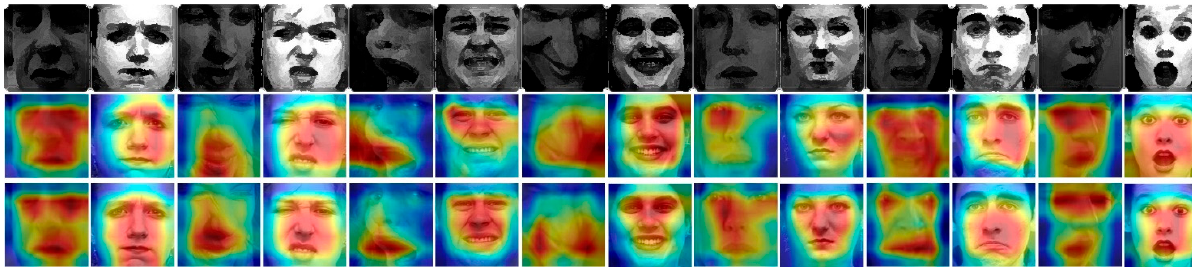
Figure 6. Visual comparison of different facial expressions (using methods with and without attention module). From top to bottom, the expression pictures, the visual results of the method without the attention module, and the visual results of the method with the attention module; From left to right, there are seven expressions (anger, disgust, fear, happy, neutral, sad, and surprised). We note that, the CK+ images (please see the seven even columns in this figure) are from the following seven subjects: s055, s052, s132, s124, s106, s113, and s074, the usage of their images has been approved. Copyright reference: http://www.jeffcohn.net/Resources/ (accessed on 9 March